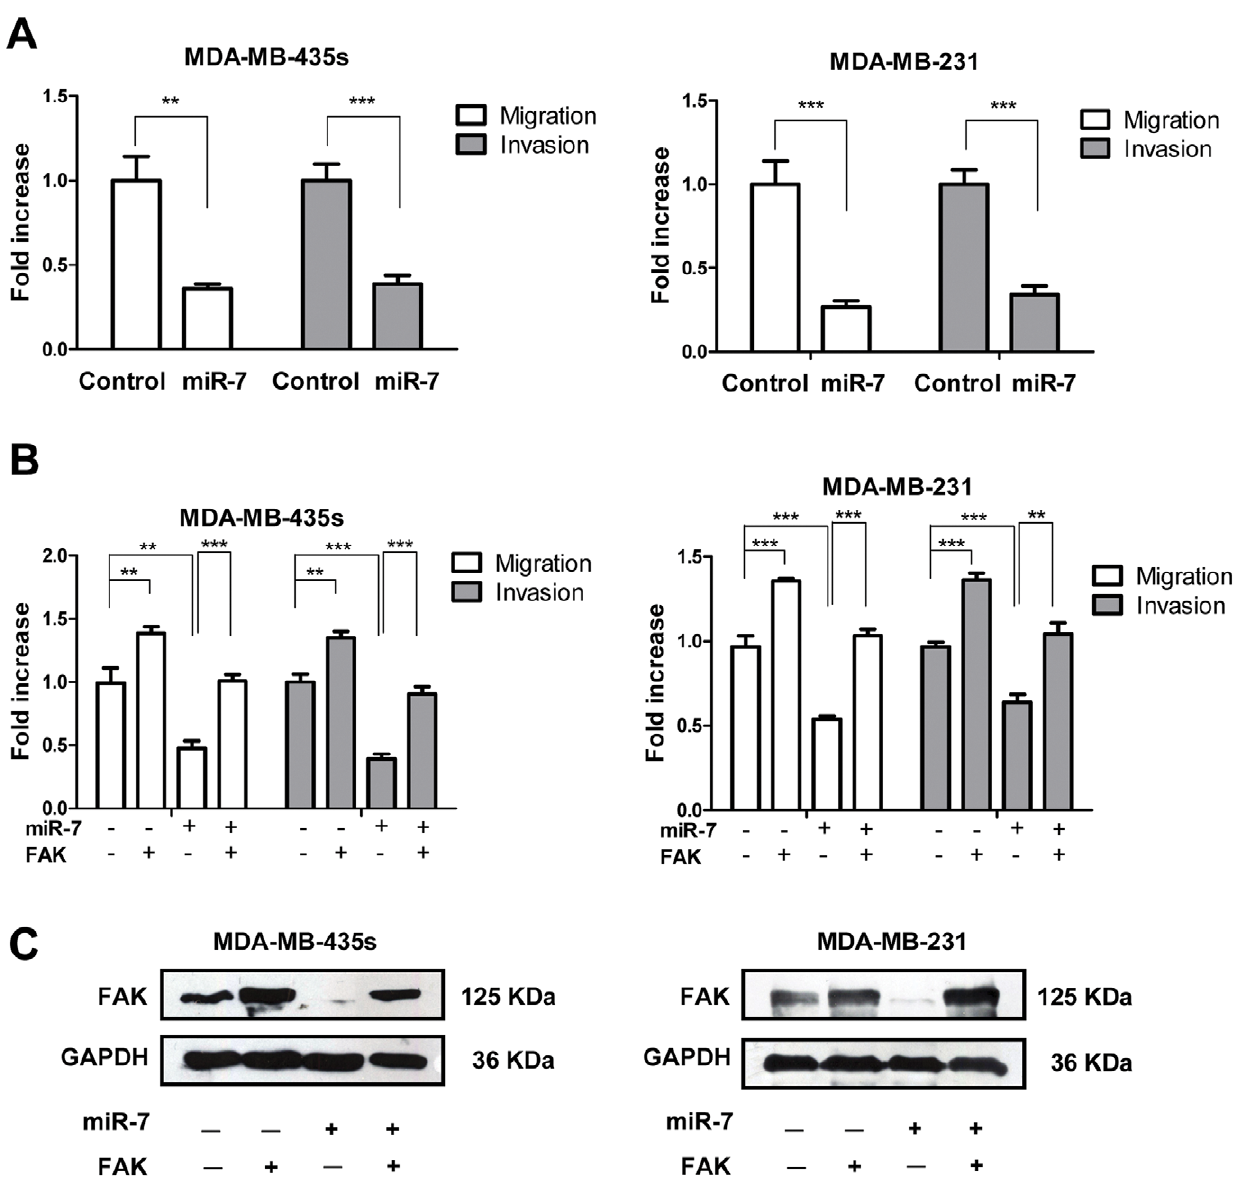
Figure 4. Restoration of FAK attenuates miR-7 mediated cell migration and invasion inhibition. (A) Transwell migration and invasion assays of MDA-MB-435s and MDA-MB-231 cells transfected with miR-7 mimics and control mimics. (B) Transwell migration and invasion assays of MDA-MB-435s and MDA-MB-231 cells transfected with miR-7 mimics and control mimics with or without FAK restoration. (C) Immunoblot analysis of FAK expression in MDA-MB-435s and MDA-MB-231 cells transfected with miR-7 mimics or control mimics with or without FAK restoration. ** p , 0.01, *** p , 0.001.